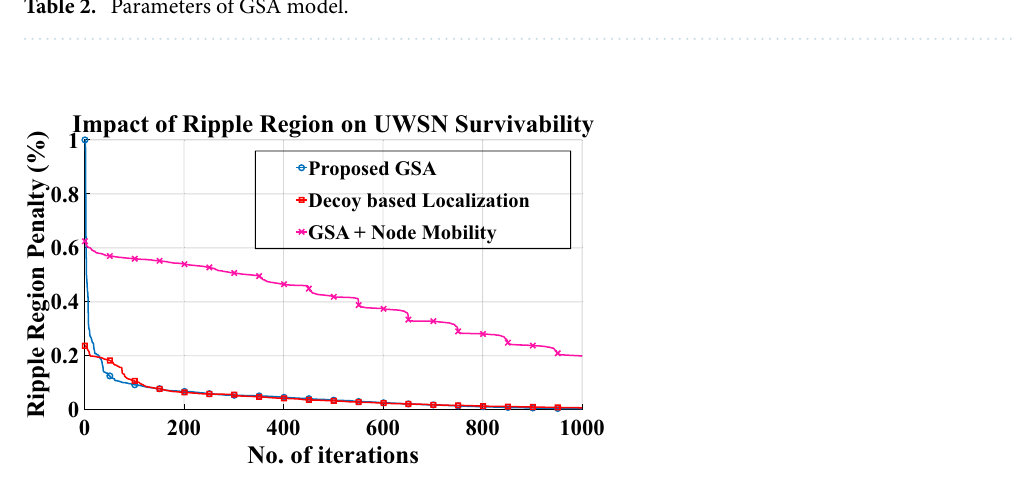
Figure 3. Impact of Ripple region on UWSN